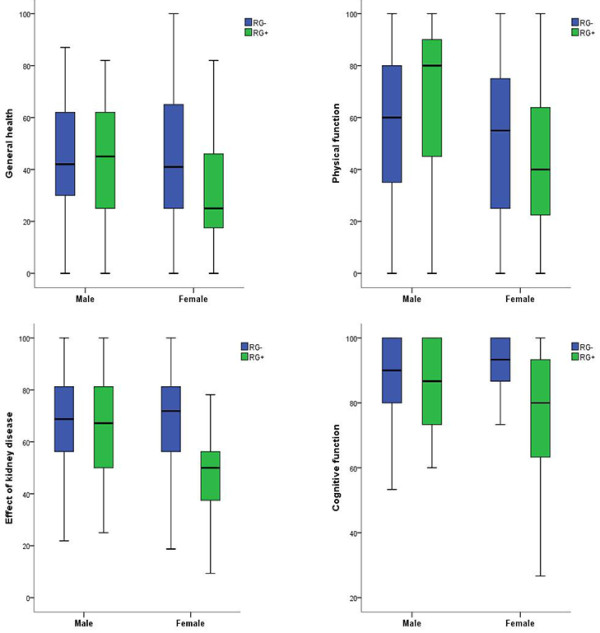
Box plots of subscales of SF-36* (upper panel) and KDQOL† (lower panel) in RG - ‡ and RG +§patients. RG - (blue bars) and RG + (green bars). Significant differences between women and men with graft loss appeared in effect of kidney disease, p = 0.017 and physical function, p = 0.006. Differences between women with and without graft loss appeared in effect of kidney disease, p = 0.002 and cognitive function, p = 0.006. Non-significant results are not listed. *The Short Form Health Survey, † KDQOL = Kidney Disease and Quality of Life, ‡RG - = Dialysis, not previously transplanted, n = 251, §RG + = Patients in dialysis with renal graft loss n = 50. Scores 0 -100, higher number indicating better QOL.